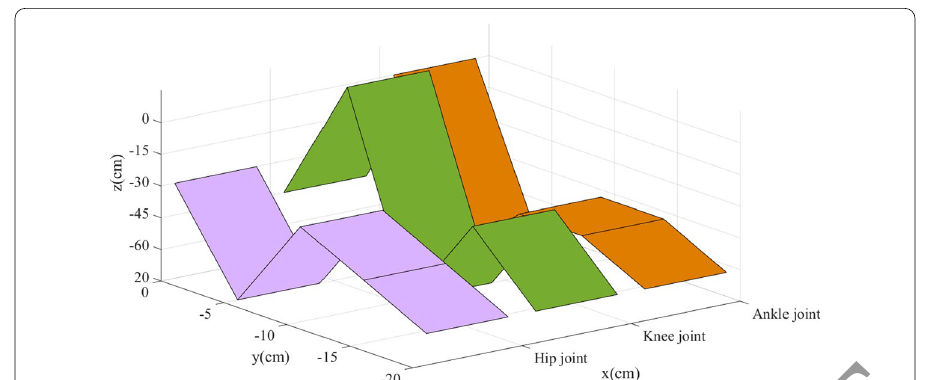
Fig. 2 The trajectory of the rootless node displacement